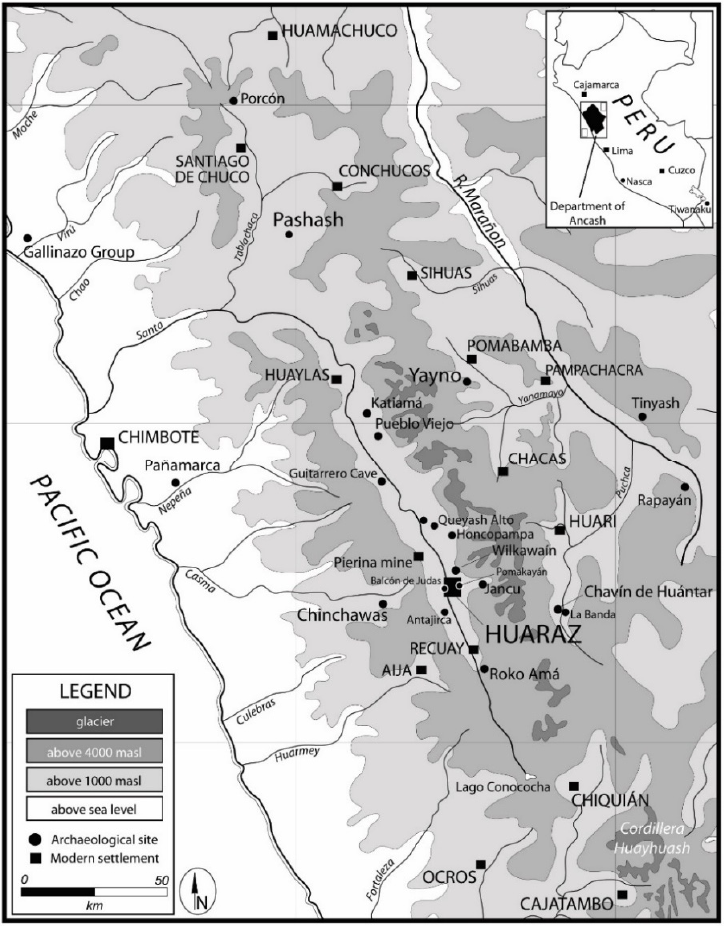
Figure 4. Map of north central Peru and places indicated in the text. Map by author.